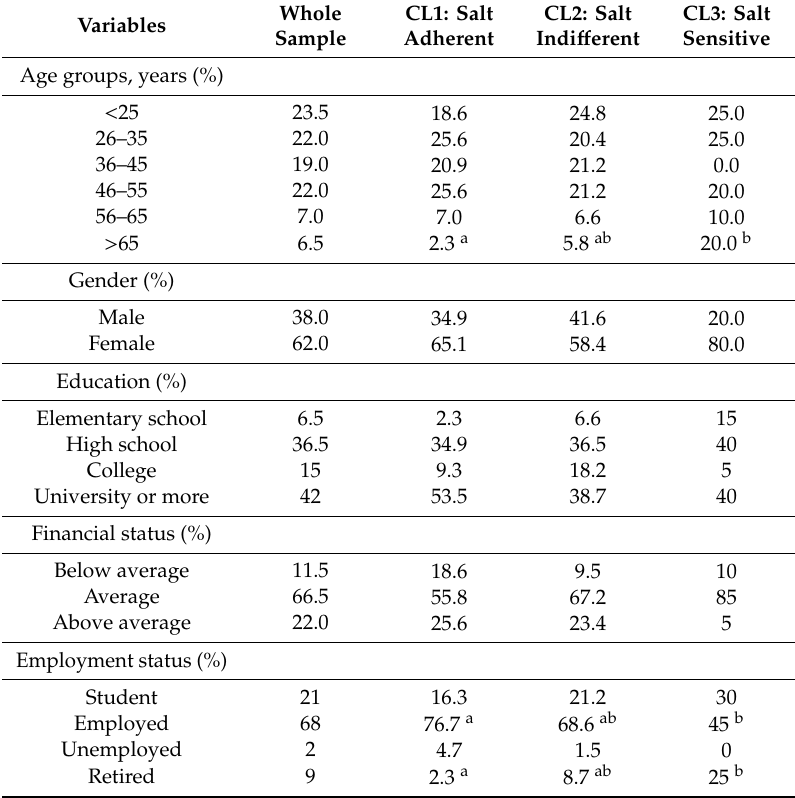
Table 6. Socio-demographic characteristics of the sample and the three clusters ( n =